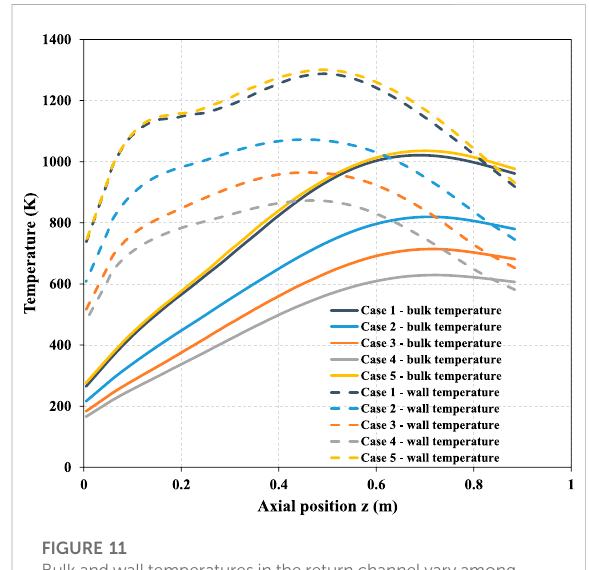
FIGURE 11 Bulk and wall temperatures in the return channel vary among different cases.